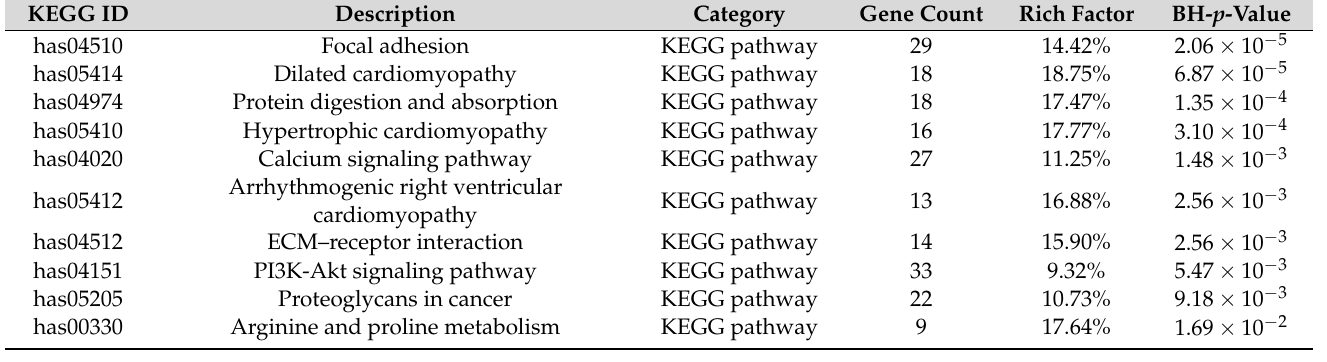
vinculin (VCL) were our hub genes. EGF and EPCAM were upregulated, and others were downregulated. Among the DEGs, EGF had the highest node degree (99). Table 3. The top 10 DEGs enrichment analysis of the KEGG pathway. KEGG, Kyoto Encyclopedia of Genes and Genomes. The Rich factor is the proportion of selected gene numbers (DEGs) compared to all gene numbers involved in each pathway term. The degree of pathway enrichment increases as the Rich factor increases.